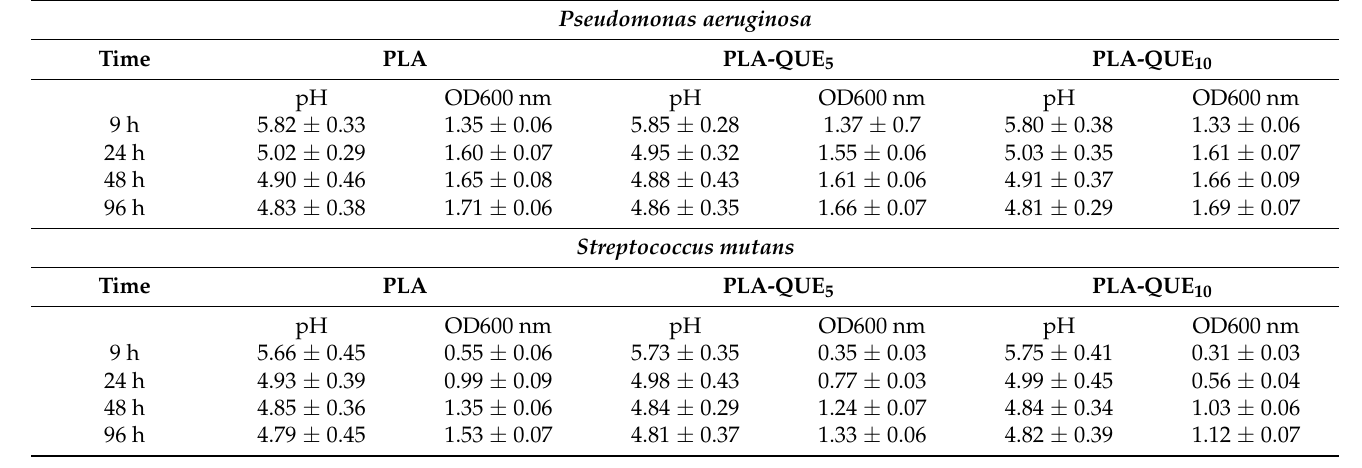
Table 3. pH and OD 600 nm of the bacterial cultures in growth medium supplemented with 20% sucrose in the presence of PLA